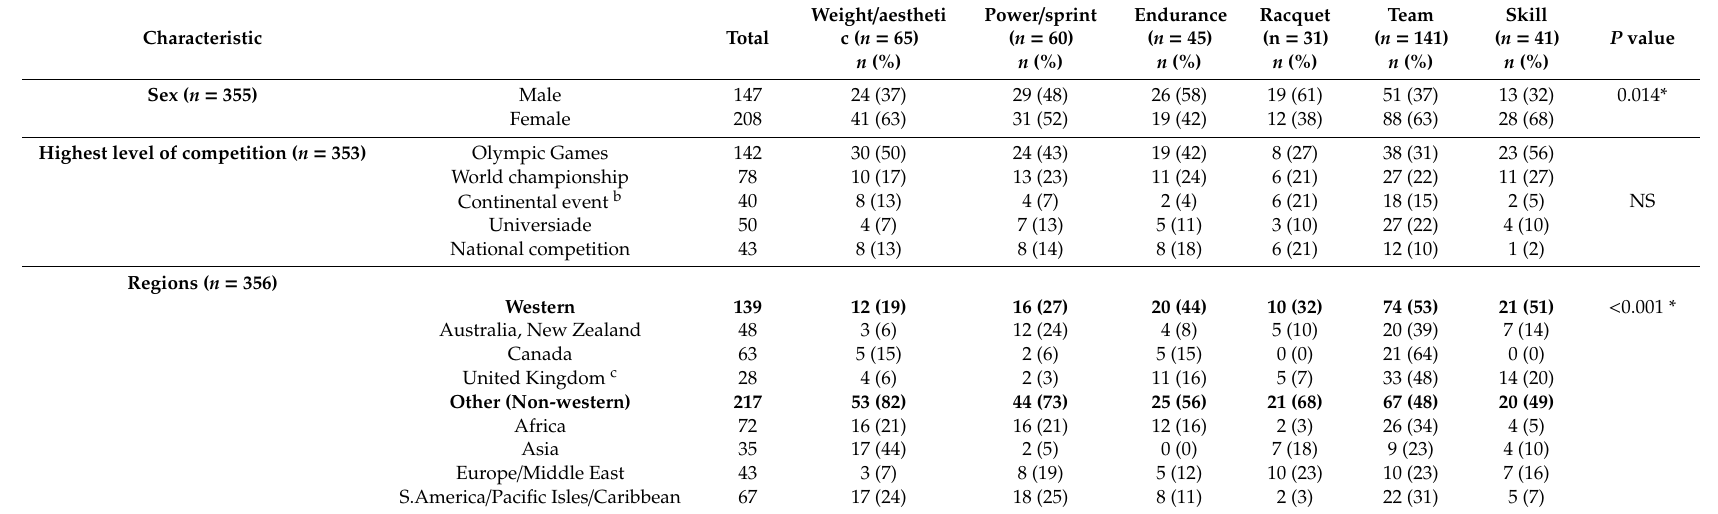
Weight / aestheti Power / sprint Endurance Racquet Team Skill P value c ( n = 65) ( n = 60) ( n = 45) (n = 31) ( n = 141) ( n = 41) n (%) n (%) n (%) n (%) n (%) n (%)